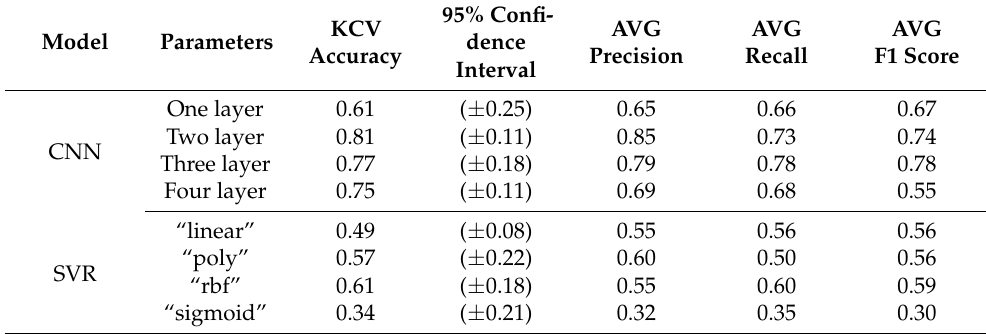
Table 4. Preliminary evaluation of the CNN and SVR using 10-fold